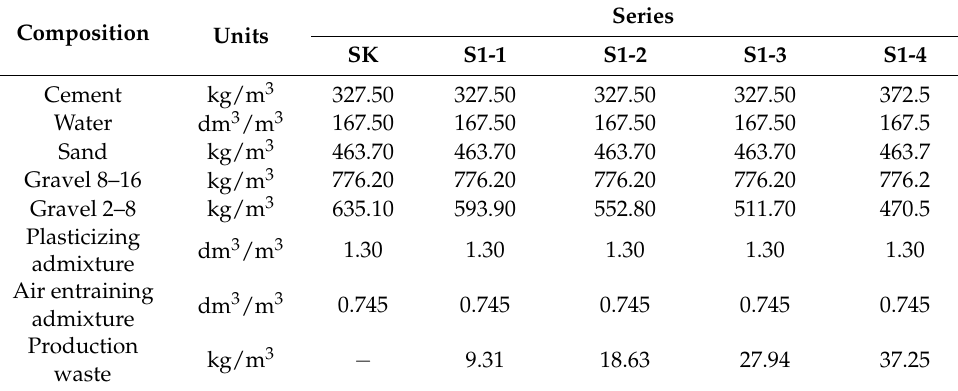
Table 2. The composition of the reference concrete and concrete modified with waste as the substitute for gravel aggregate with a particle size distribution of 2–8